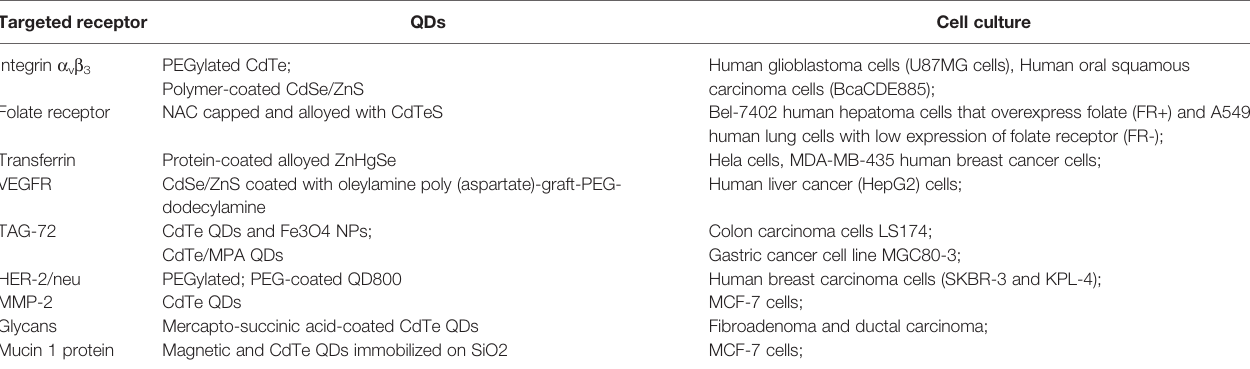
TABLE 1 | Selected reports on applications of QDs in cancer